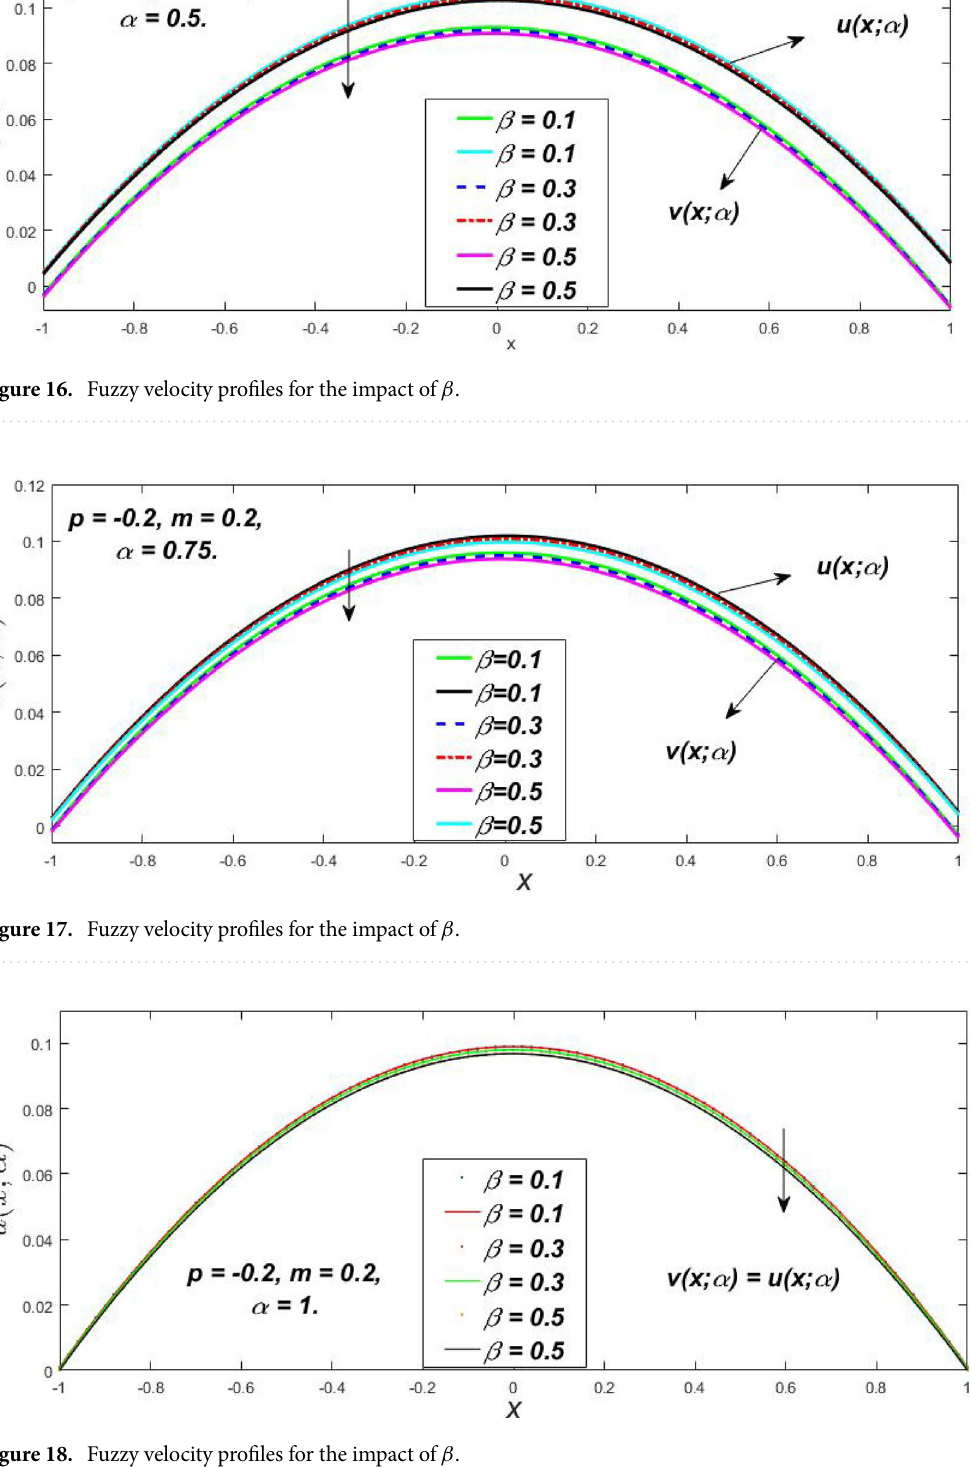
Figure 18. Fuzzy velocity profiles for the impact of β